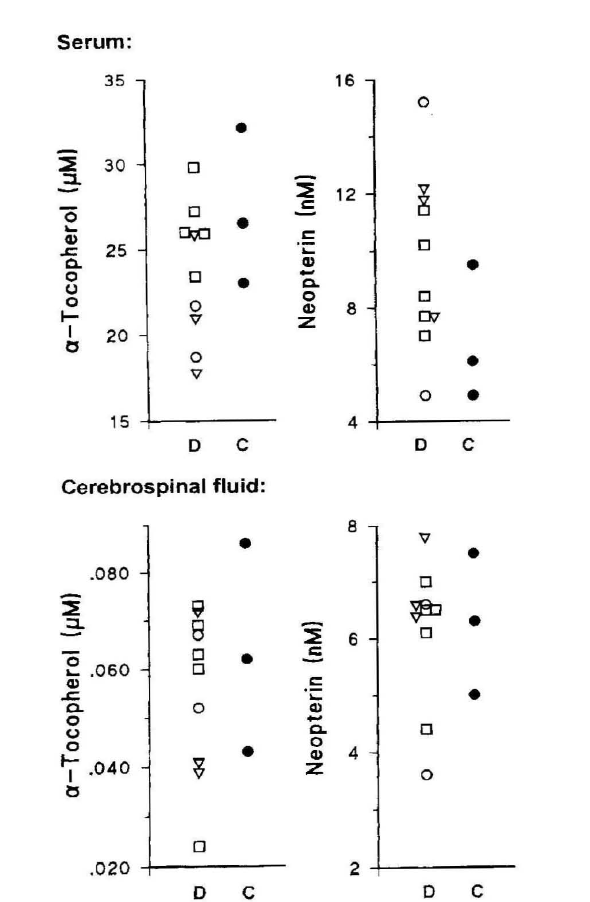
Figure I . Concentrations of neopterin and a-tocopherol In senlm and cerebrospinal fluid of patients with dementi as (D ): 5 with Alzheimers disease (open squares), 2 with Hlli1tingrons disease (open circles), 3 with vascular dementia (open triangles) and controls (C): 11=3 (closed circles). Pteridines / Vol. IO / ~o.